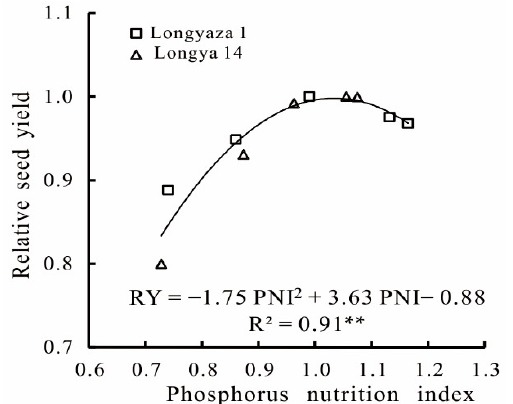
Figure 8. Relationship between relative seed yield (RY) and phosphorus nutrition index (PNI) for two flax cultivars. The PNI data were averaged over two years. ** Significance at p < 0.01 probability